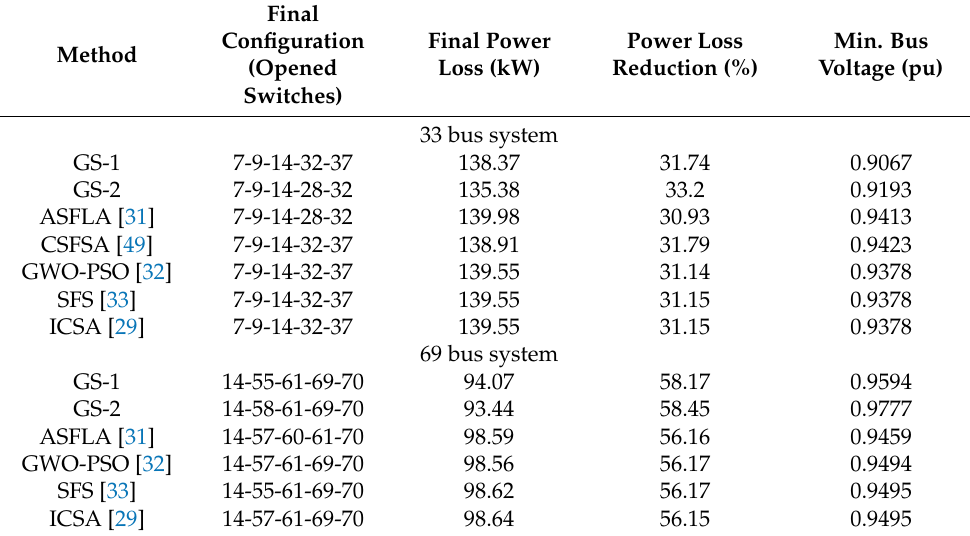
Table 5. Comparison of GS-1 with other